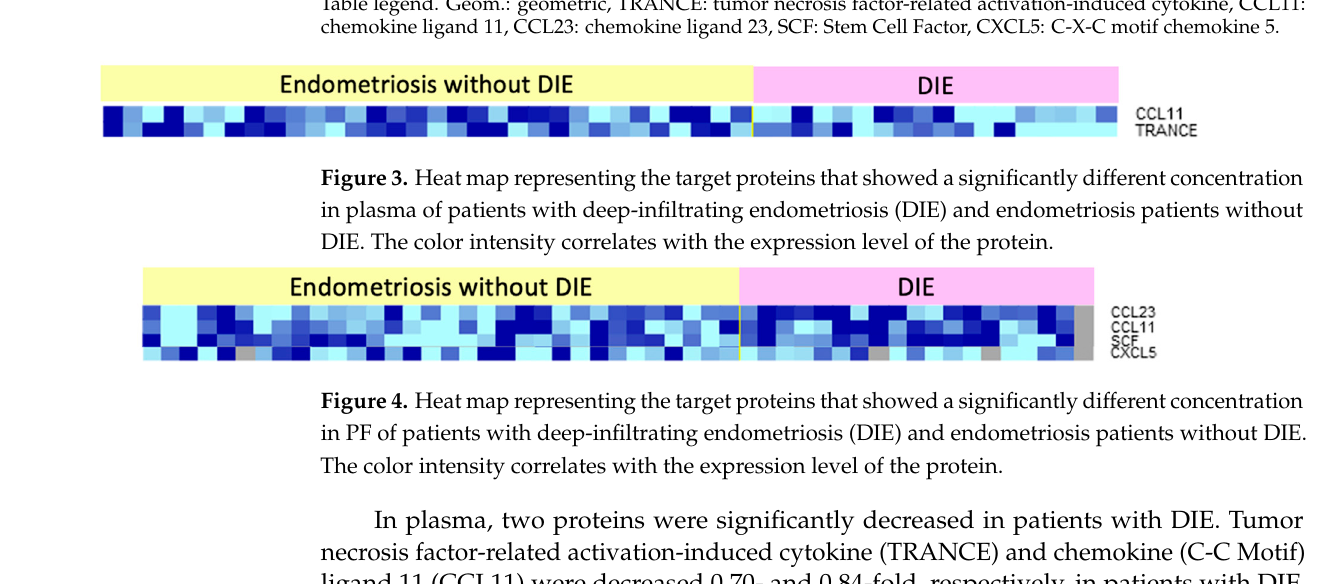
Table legend. Geom.: geometric, TRANCE: tumor necrosis factor-related activation-induced cytokine, CCL11: chemokine ligand 11, CCL23: chemokine ligand 23, SCF: Stem Cell Factor, CXCL5: C-X-C motif chemokine 5.